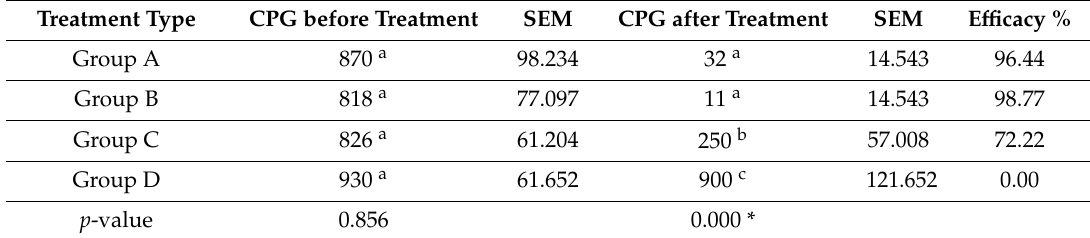
Table 6. B. sulcata cyst count before and after treatment in the drug-treated, garlizine-treated, and untreated control groups (for two weeks). CPG: cysts per gram of